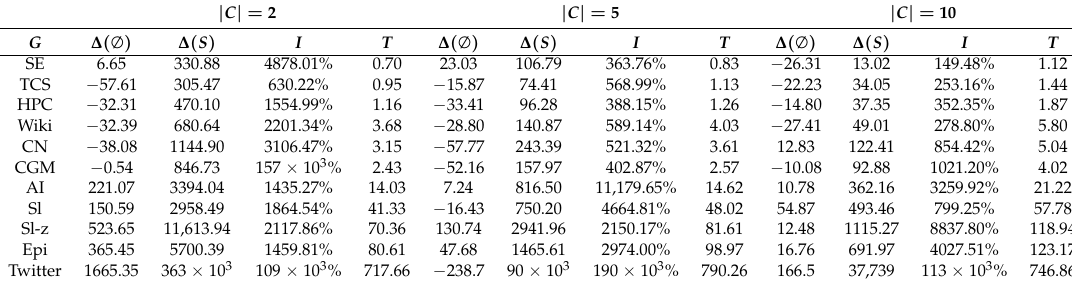
Table 2. Results for real-world networks. ∆ ( ∅ ) = F A ( ˆ c , S ) , where c and ˆ c are the candidates, different from c (cid:63) , with the highest score before and after F A 0 the process has quiesced.